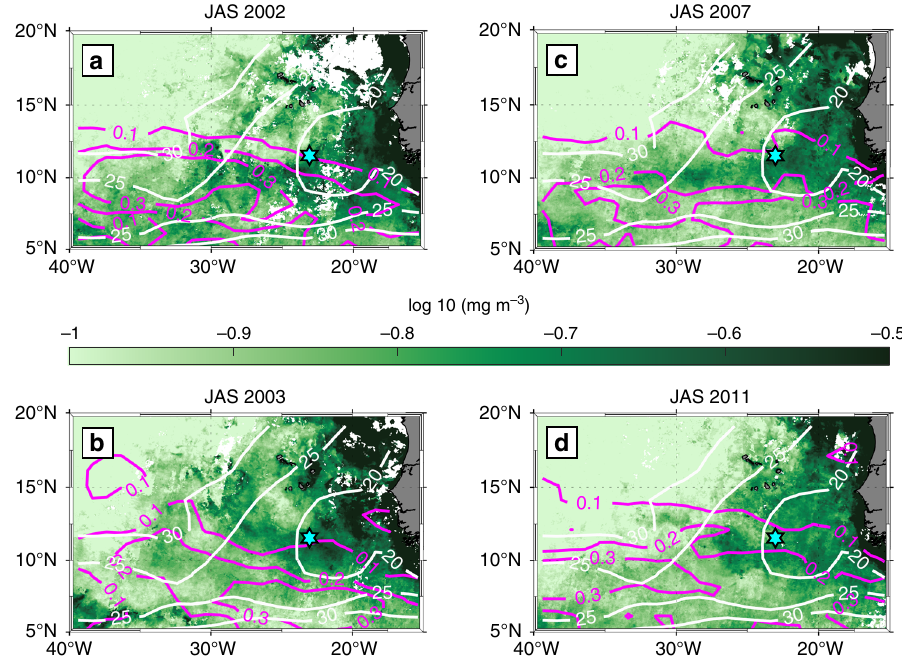
Fig. 10 Boreal summer chlorophyll a distribution for exemplary years. July – September (JAS) chlorophyll a distribution during a 2002, b 2003, c 2007, and d 2011. Magenta contours show the seasonal prevalence of near inertial wave events (as in Fig. 8c), but for the respective years; white contours show the corresponding mixed layer depth from the MIMOC climatology as in Fig. 8c (the latter without interannual variations). The cyan star marks the position of the PIRATA buoy at 11.5°N,